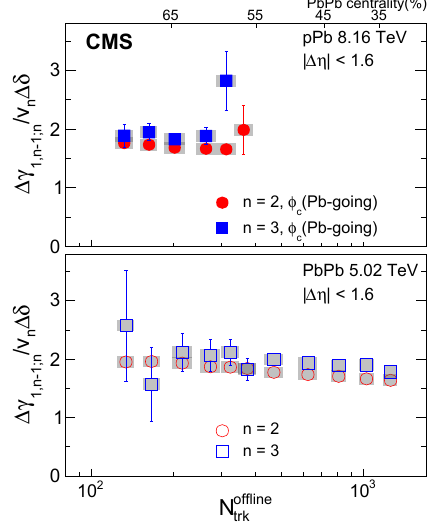
< 1 . 6, in pPb collisions for ∆ η | |